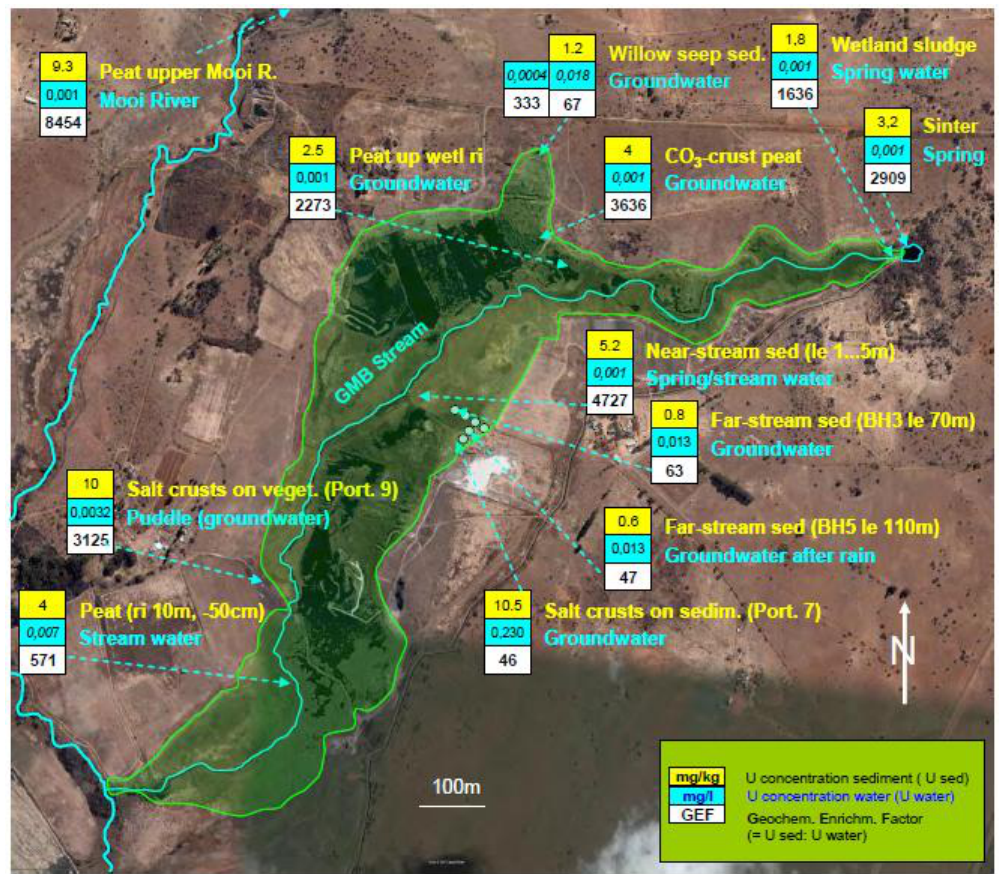
Figure 14. U concentrations and geochemical enrichment factors (GEF) for selected sediment-water systems in the Gerhard Minnebron wetland (map based on satellite image of the study area as retrieved from Google